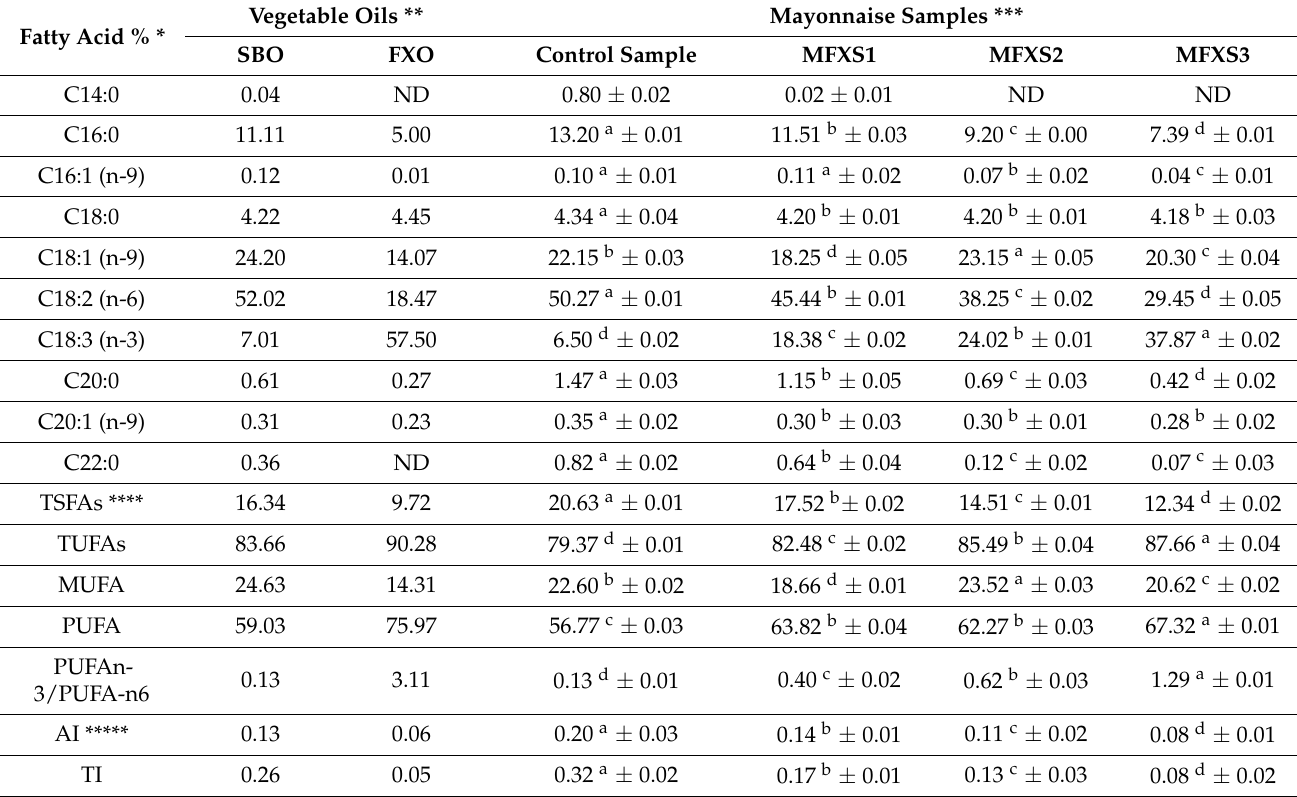
Table 1. Fatty acid profiles of vegetable oils and mayonnaise